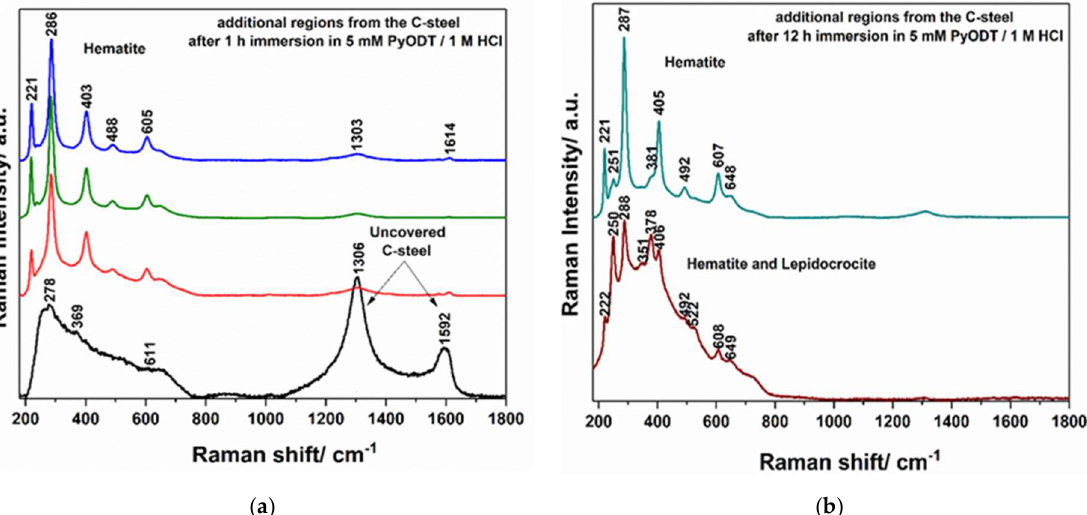
Figure 12. Raman spectra recorded on various additional regions of the C-steel after 1 h ( a ) and 12 h ( b ) of exposure to 5 mM PyODT-containing